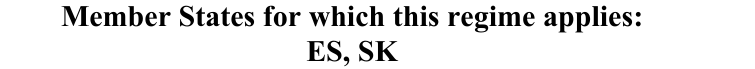
Figure 17: Registration and certification of the entire production and monitoring process in accordance with existing regulations and standards Member States for which this regime applies: ES, SK